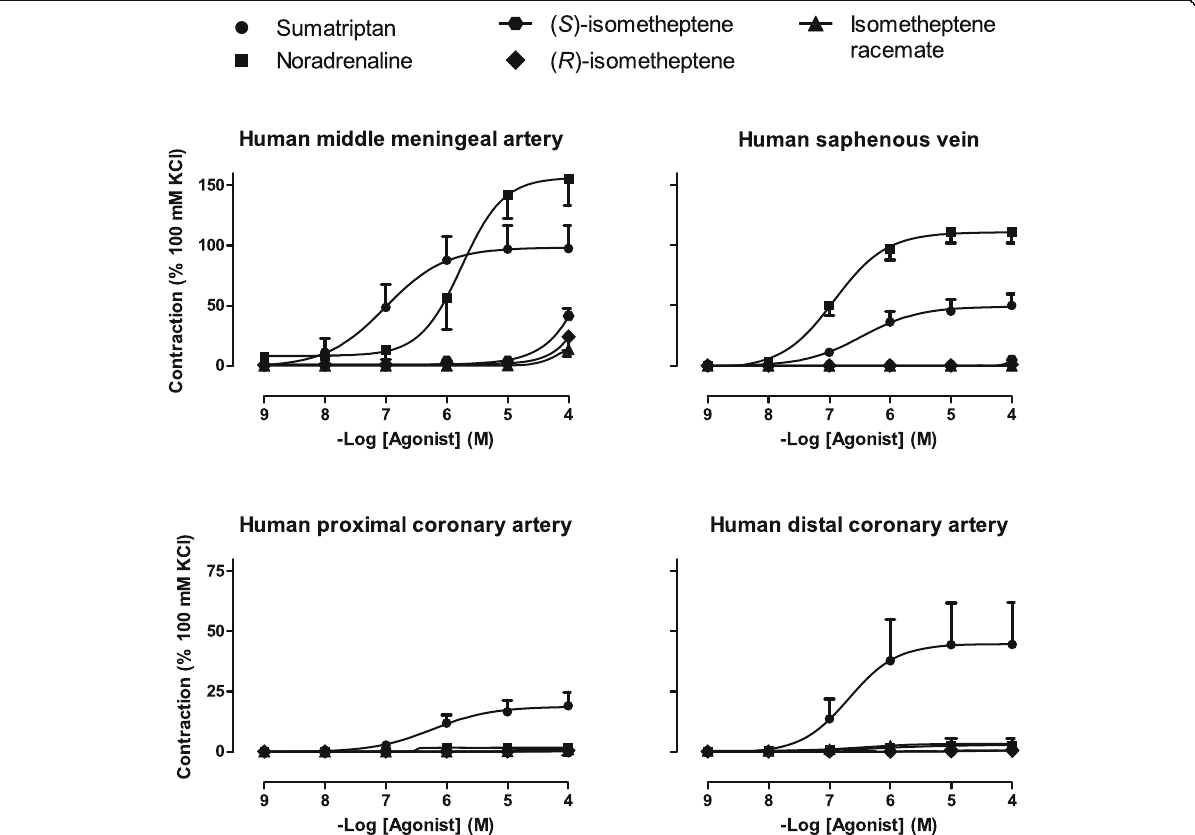
Fig. 1 Concentration response curves to sumatriptan, noradrenaline, isometheptene enantiomers and isometheptene racemate on the middle meningeal artery ( n =6 – 7), saphenous vein ( n =7 – 10), as well as proximal (n=7 – 10) and distal ( n =8 – 9) coronary